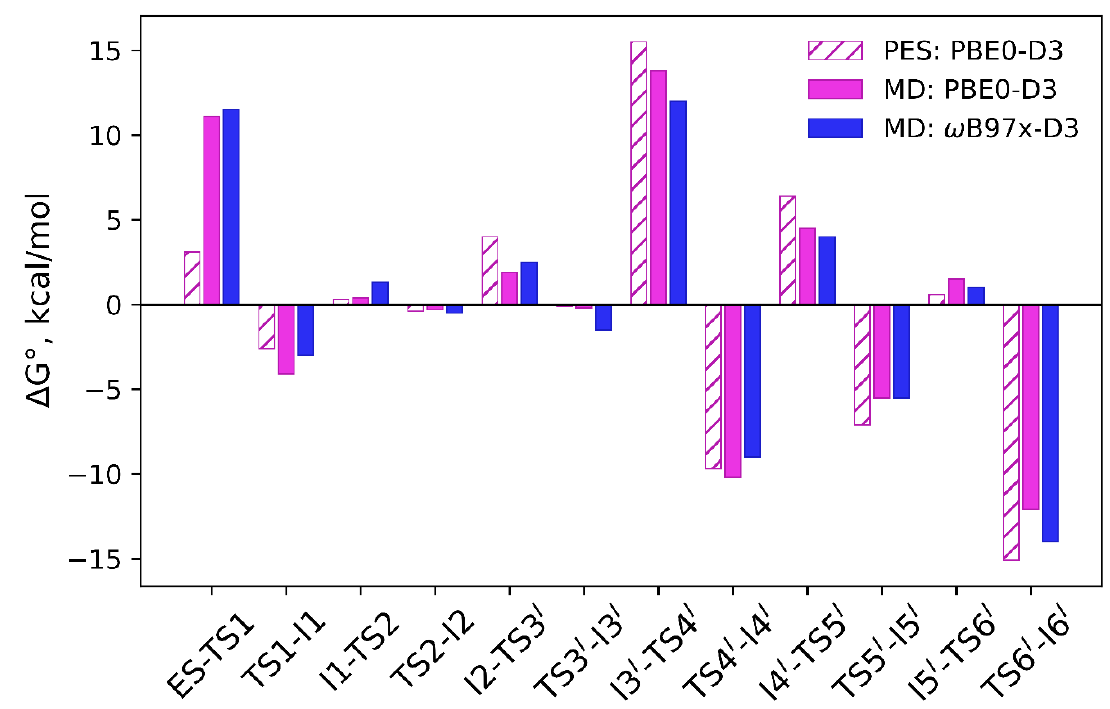
Figure 5. Gibbs energy differences between the neighboring minima and transition states. Pink bars correspond to the Gibbs energies obtained from the PES scan [26] with the subsequent addition of zero-point energies and entropic and thermal contributions, according to the statistical thermodynamic formulae. Magenta and blue bars correspond to the values obtained in this study using the umbrella sampling/umbrella integration method at the Kohn Sham PBE0-D3 and ωB97x-D3 levels, respectively.